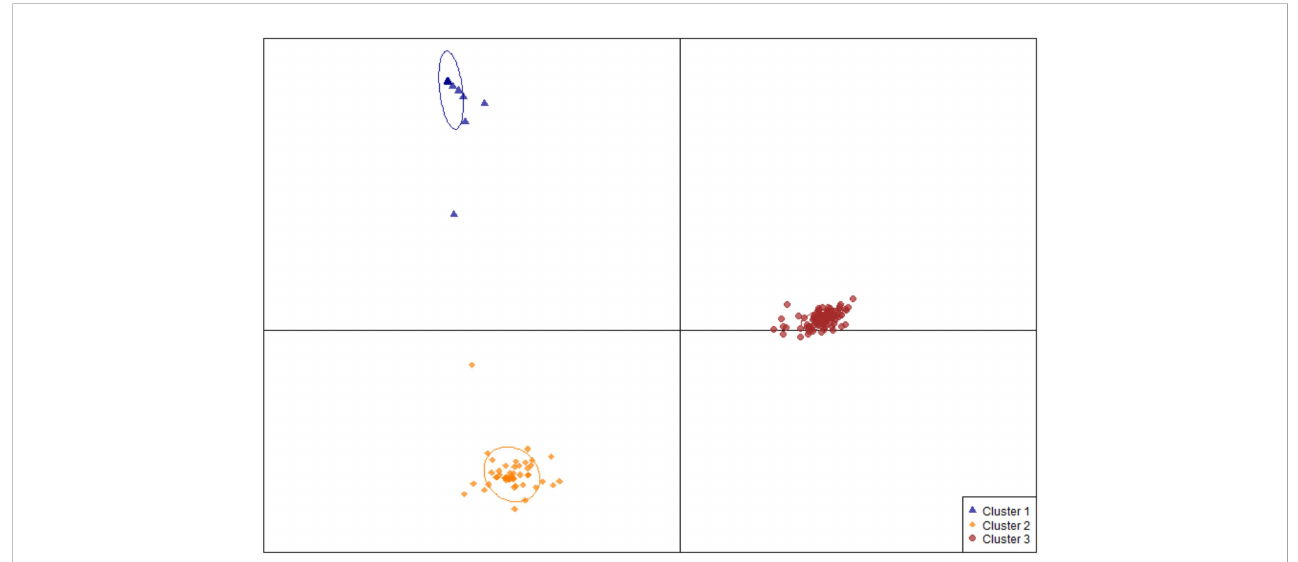
FIGURE 3 Population structure of edamame germplasms used in this study. A scatter plot depicting the three clusters identi fi ed as likely subpopulations within the 189 accessions: cluster I (blue triangle, n = 27), cluster II (gold diamonds, n = 54), cluster III (red circles, n =